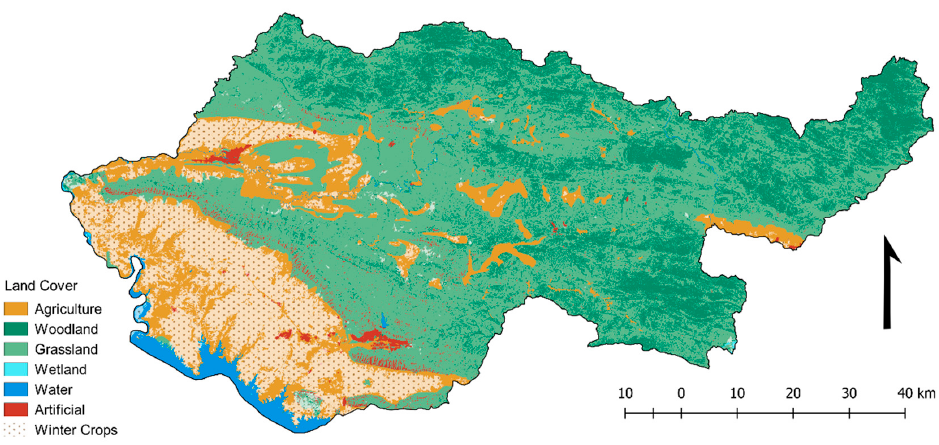
Figure 3. Land cover in the Duhok governorate by 2010 based on Globeland30 (provided by National Geomatics Center of China, DOI:10.11769/GlobeLand30.2010.db). Winter crop areas for the period 1998–2014 are superimposed on the land cover classification.